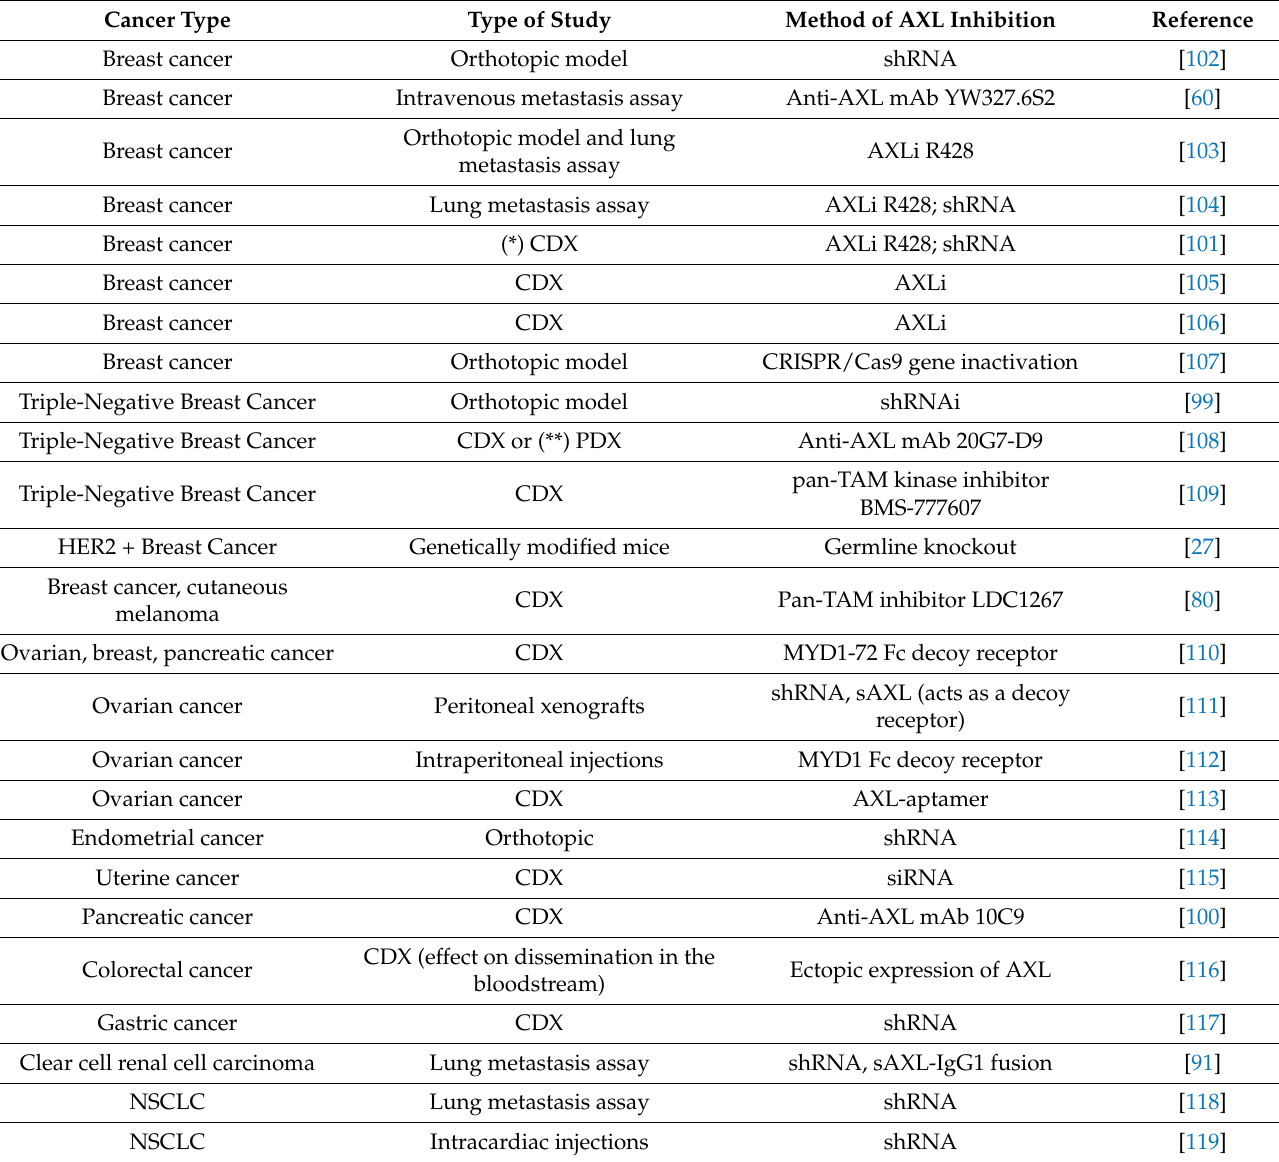
Table 2. In vivo models demonstrate essential role of AXL in cancer